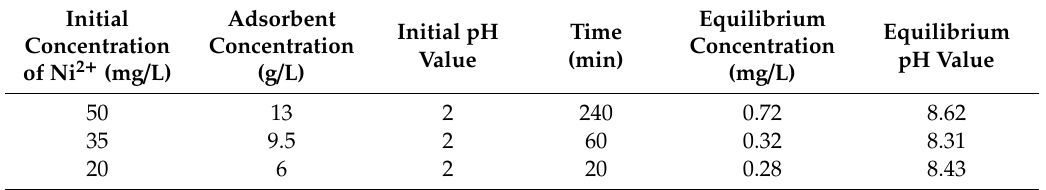
Table 6. The adsorption results of CFAMH for Ni 2 +